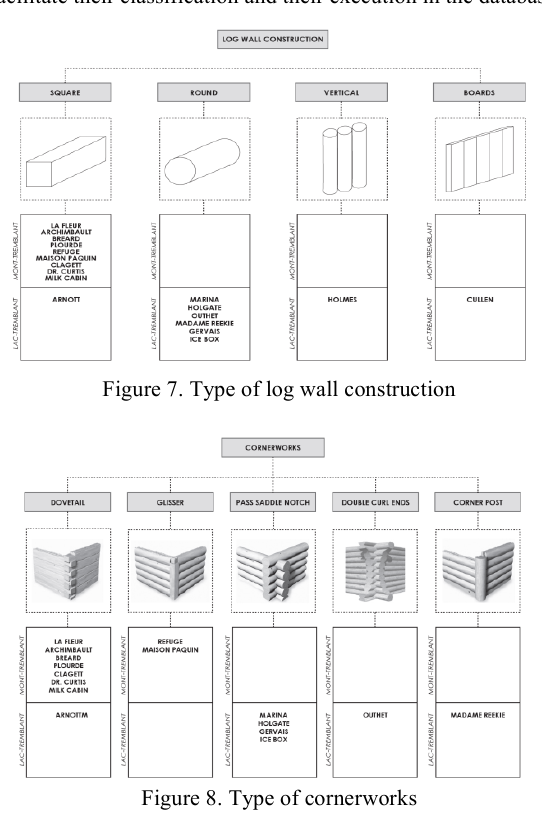
Figure 8. Type of